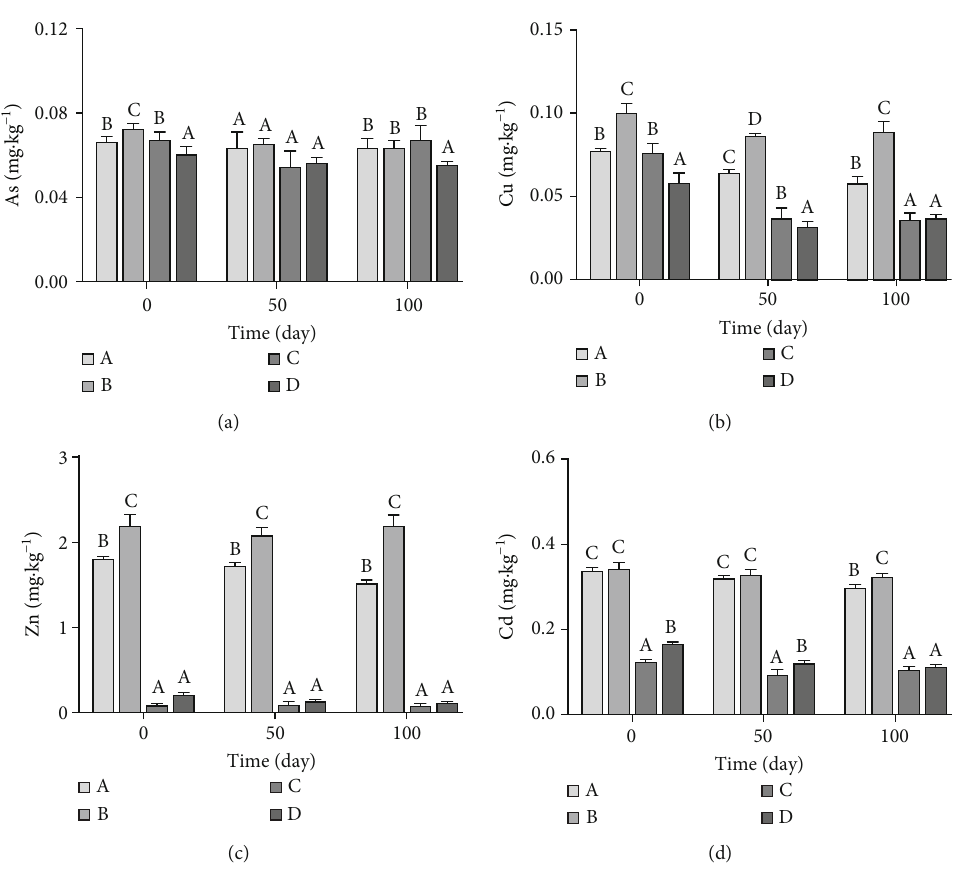
Figure 2: E ff ect of amendments on the concentration of CaCl -extractable heavy metals: As (a), Cu (b), Zn (c), and Cd (d) in soils. Di ff erent 2 letters above bars indicate signi fi cant di ff erences between mean values at each sampling occasion ( P < 0.05).